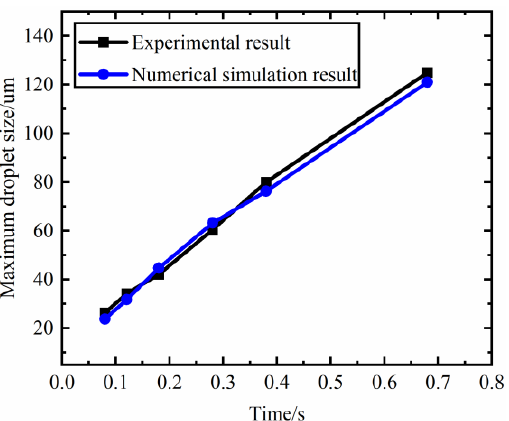
Figure 7. Comparison of maximum droplet size range between numerical simulation and experi- ment [47].